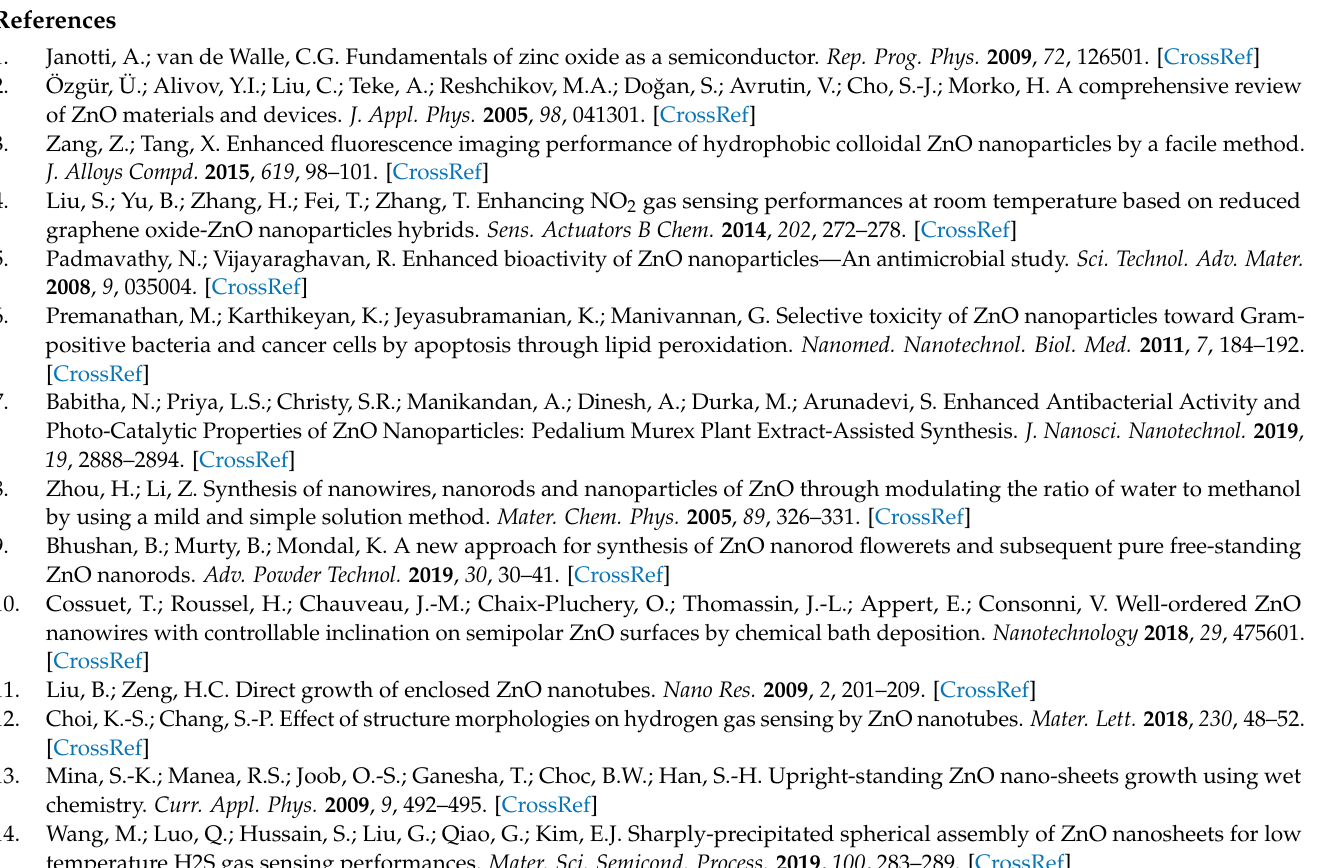
for the heating of ZnO prepared using Zn(nitrate) 2 and hydrazine. Figure S13: Thermogravimetric analysis (TGA) and mass spectrometry (MS) curves for the heating of ZnO prepared using Zn(nitrate) 2 and Tris. Figure S14: Infrared spectra of ZnO prepared using [Zn(acetate) 2 (Tris) 2 ], [Zn(acetate) 2